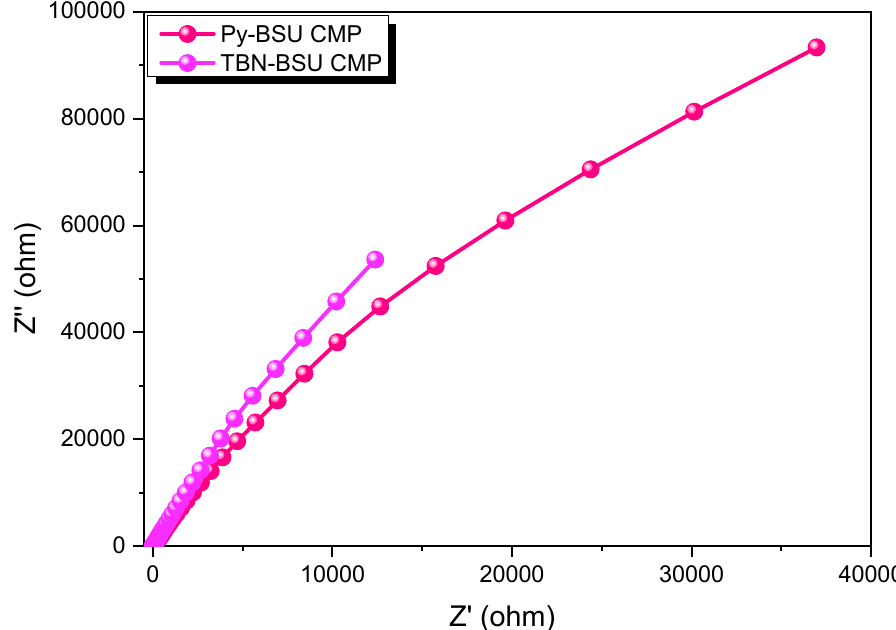
Figure 7. Electrochemical impedance spectroscopy (EIS) of Py-BSU CMP and TBN-BSU CMP elec- trode materials, recorded at 0.5 Hz.